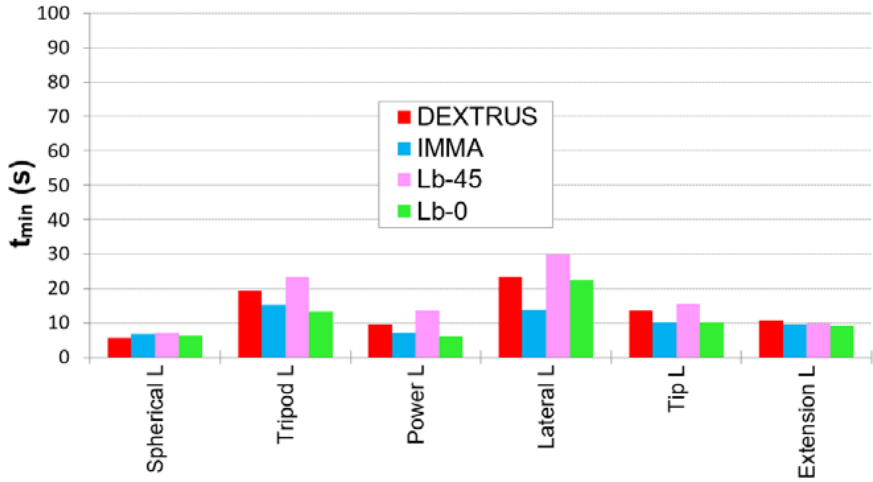
Figure 8. Fastest time ( t min ) ever registered for each of the LAO tasks.